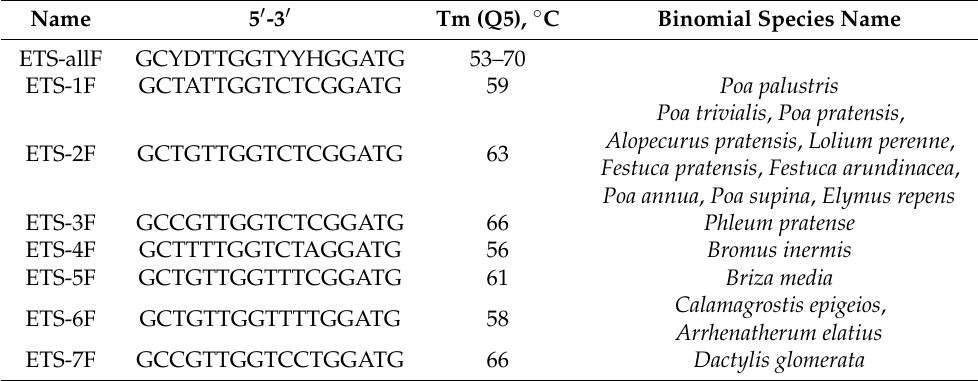
Table 2. 5 (cid:48) -ETS forward